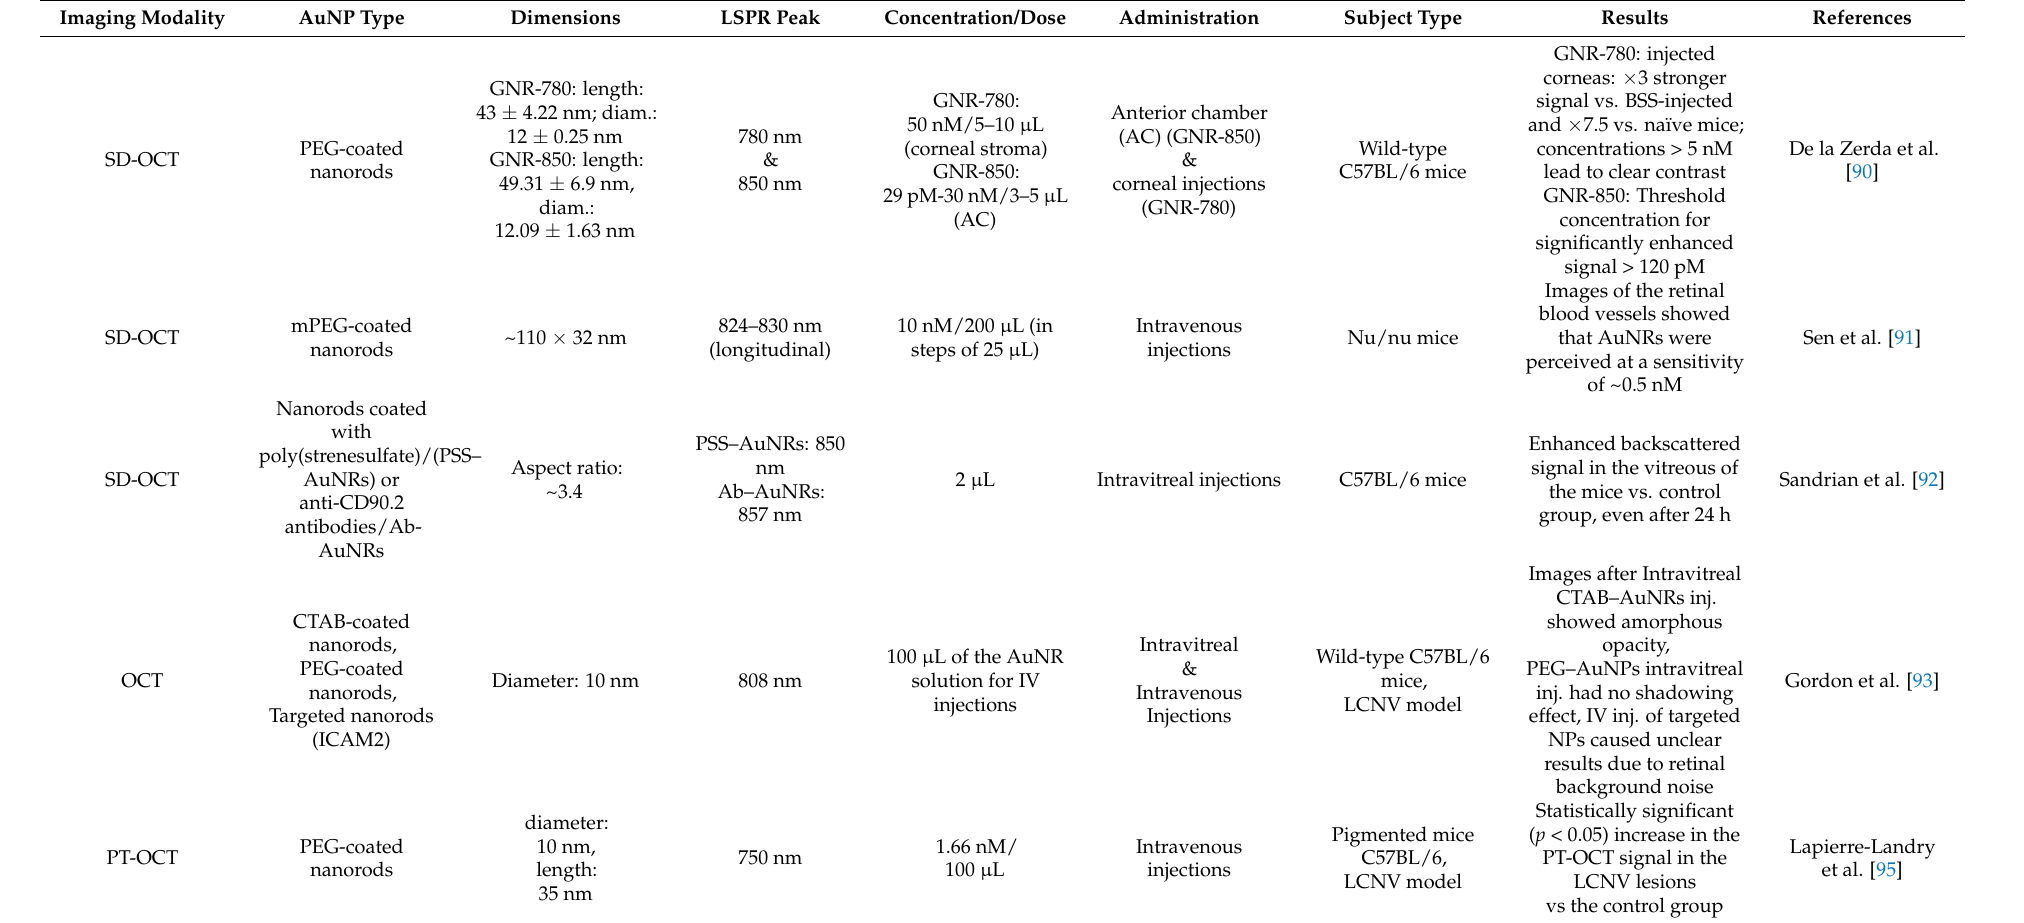
Table 2. In vivo studies examining the use of gold nanoparticles as contrast agents for OCT &